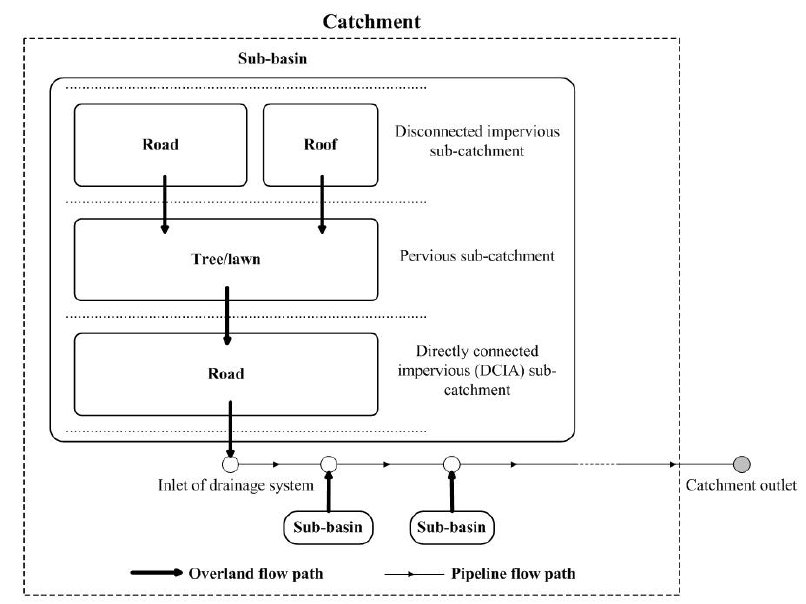
Figure 3. Illustration of catchment structure and flow pathways in SWMM.